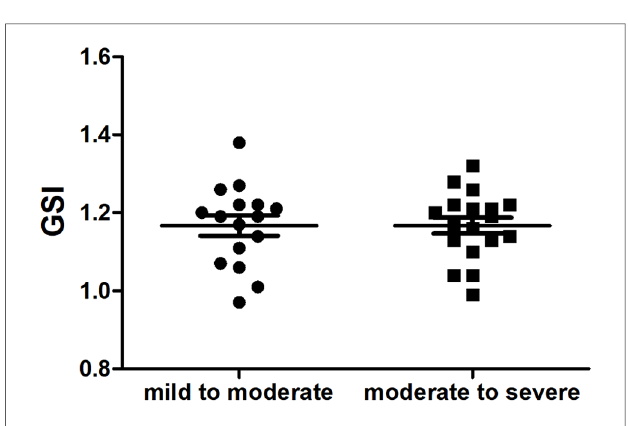
FIGURE 4 Scatter plot of global sphericity index (GSI) in the fetuses with mild to moderate and moderate to severe DA Con ( P